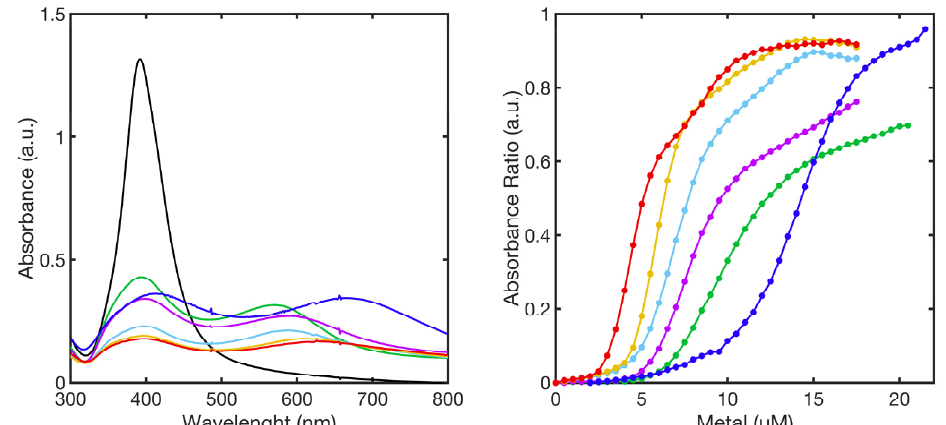
Figure 12. SPABs of PL 2 -AgNPs@11MUA (black line) obtained at the highest concentration of metal ions ( left -panel), calibration curve showing the relationship between absorbance ratio and metal ions concentration used in the titrations ( right -panel). Ni 2+ (green line), Mn 2+ (blue line), Cu 2+ (red line), Zn 2+ (cyan line), Co 2+ (purple line), and Cd 2+ (yellow line).